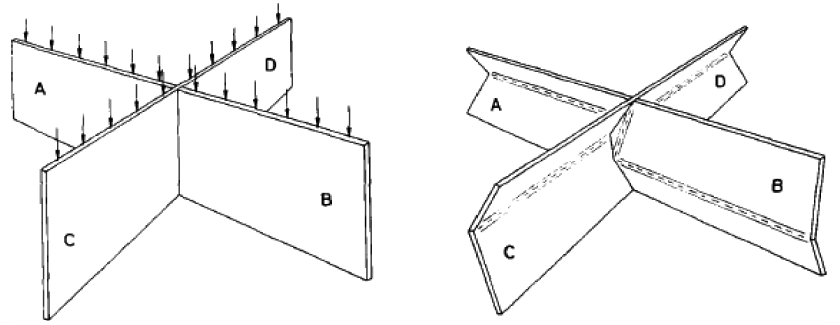
Fig. 3. Crushing mechanism for a cruciform structural element